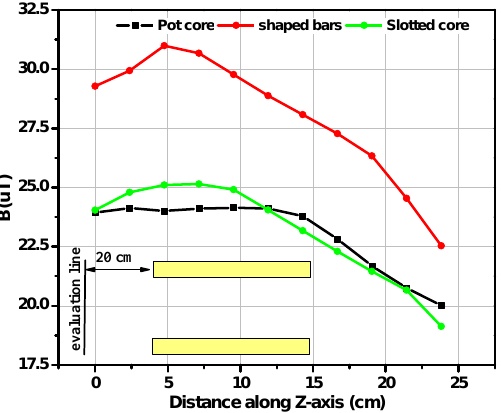
Figure 9. B rms along a line located vertically 20 cm from the pad edge.